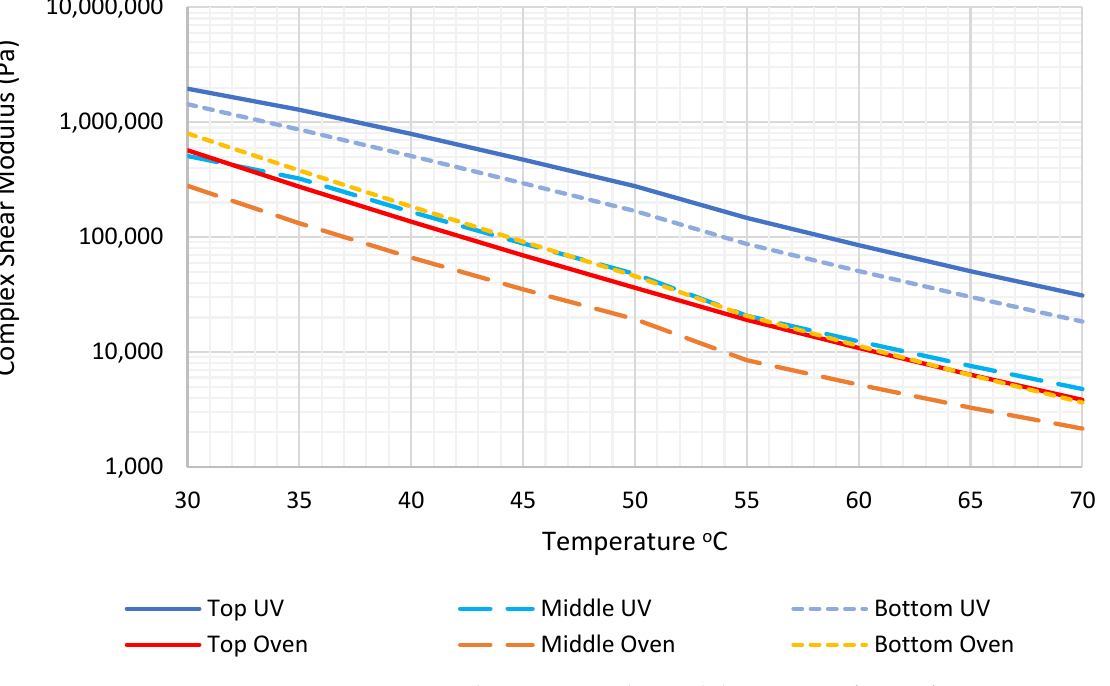
Figure 2. Temperature and average complex modulus at 1 Hz reference frequency.